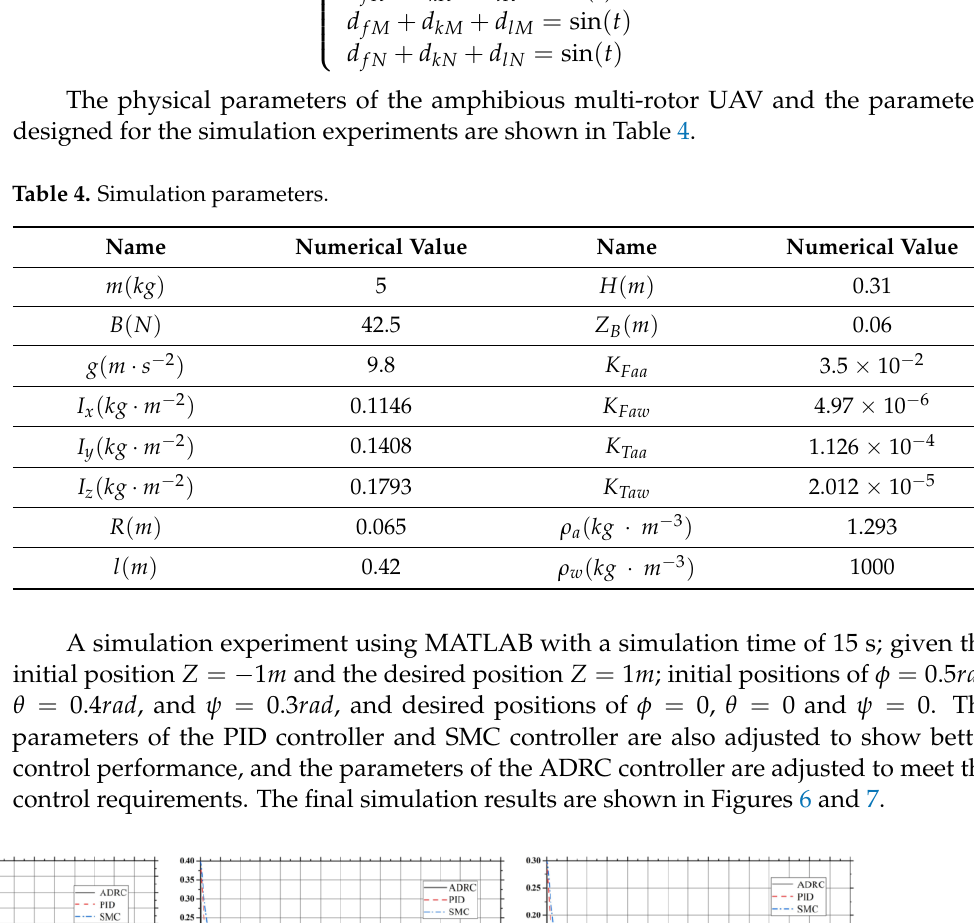
Figure 7. Comparison of simulation results of PID, SMC, and ADRC outgoing water motion height control.